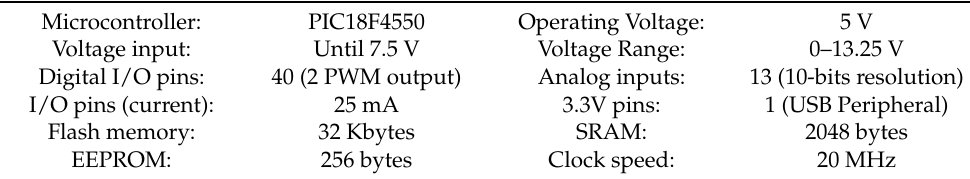
Table 1. Microchip ® microcontroller features [26].